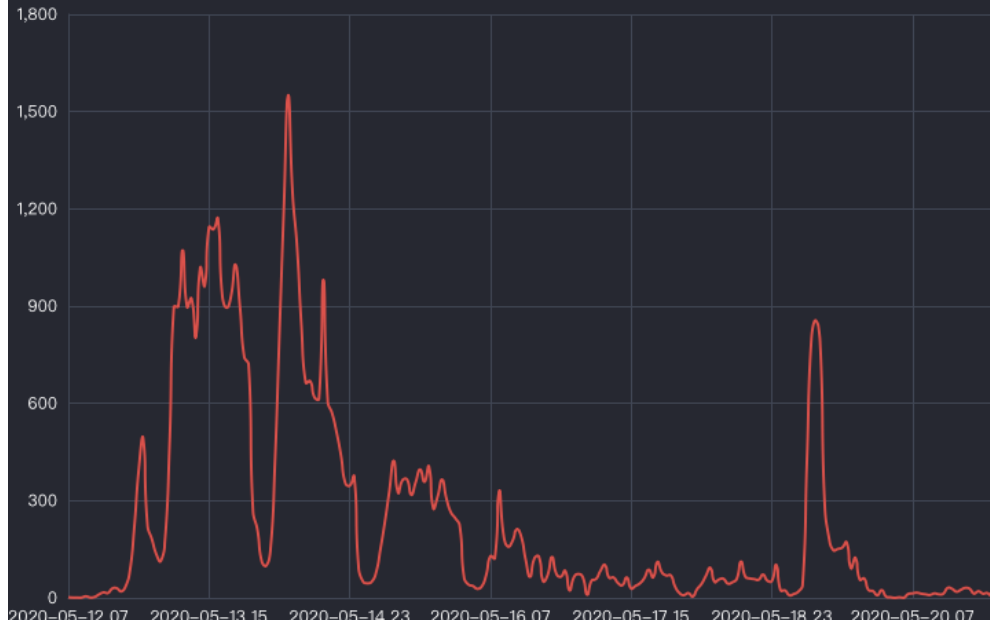
Figure 1. Development trend chart of online public opinion on the “fake milk powder leads to the emergence of big head babies” story. Image comes from Zhiweidata, a website that collects information from the whole network to calculate the communication effect and authoritative indicators of a single event on the Internet, so as to obtain the event influence index and the trend of online public opinion. https://ef.zhiweidata.com/event/b6e0c0e62114908a10034457/trend (accessed on 20 May 2021).